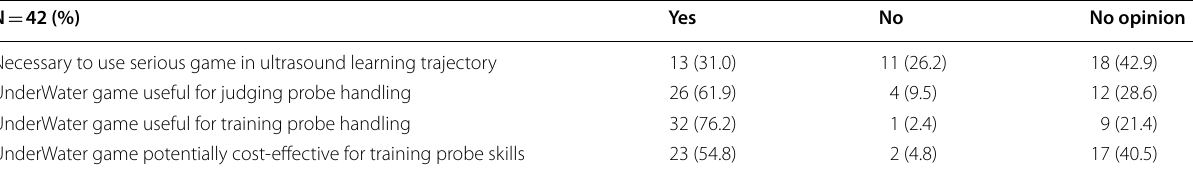
calculations of multiple